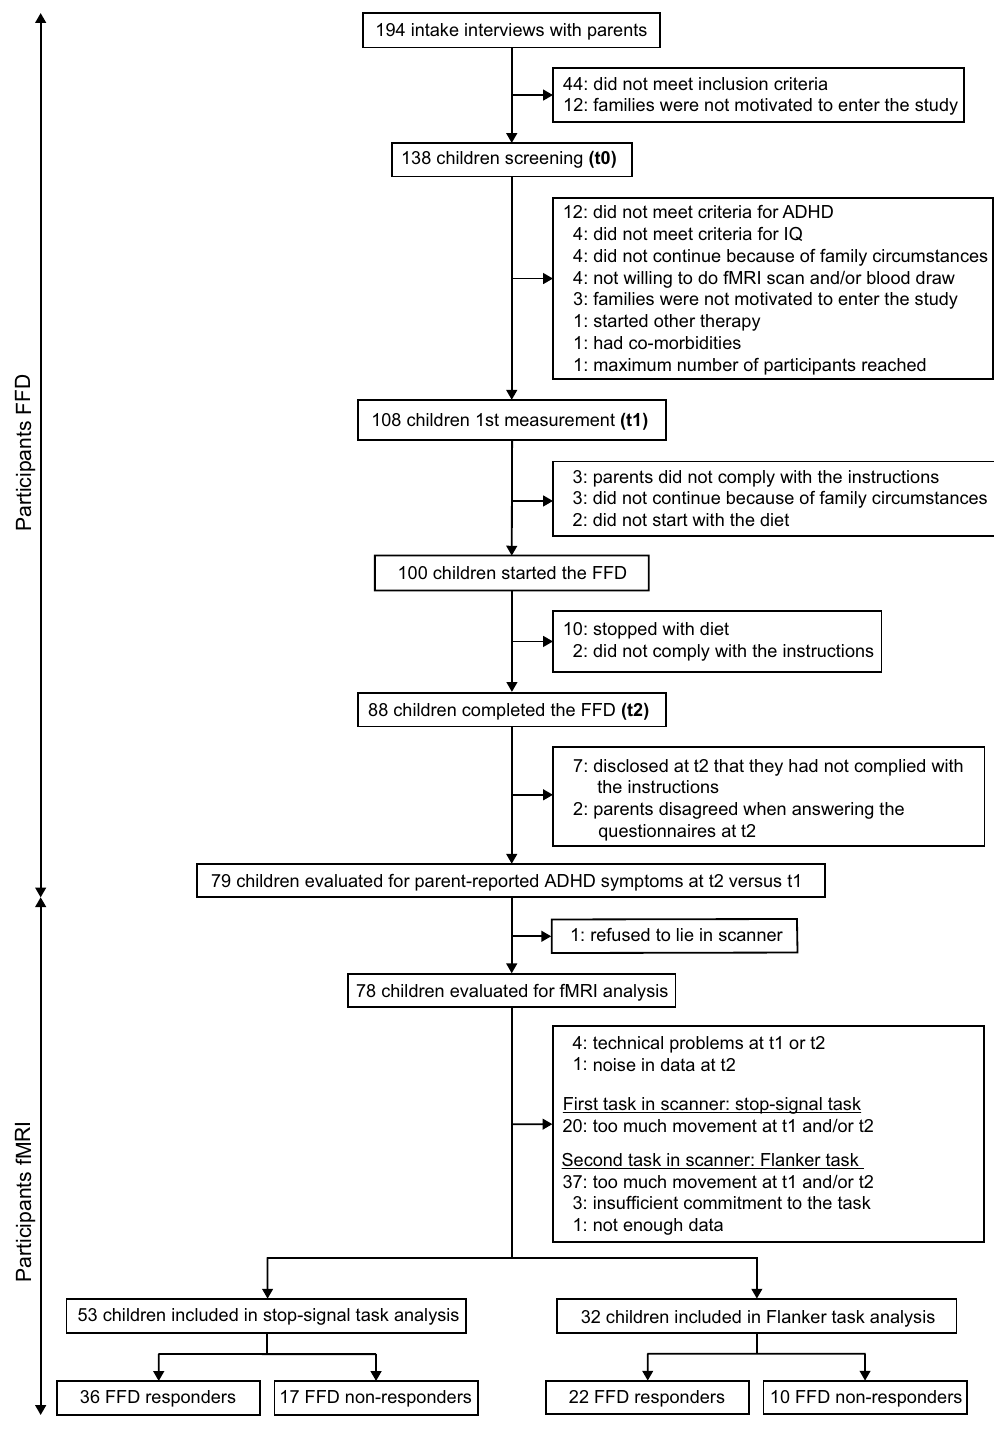
Figure 1. Flowchart participants FFD and fMRI. ADHD attention-deficit hyperactivity disorder, FFD few- foods diet, IQ intelligence quotient, Non-resp non-responder (< 40% ARS score decrease at t2 compared to t1), Resp responder (≥ 40% ARS score decrease at t2 compared to